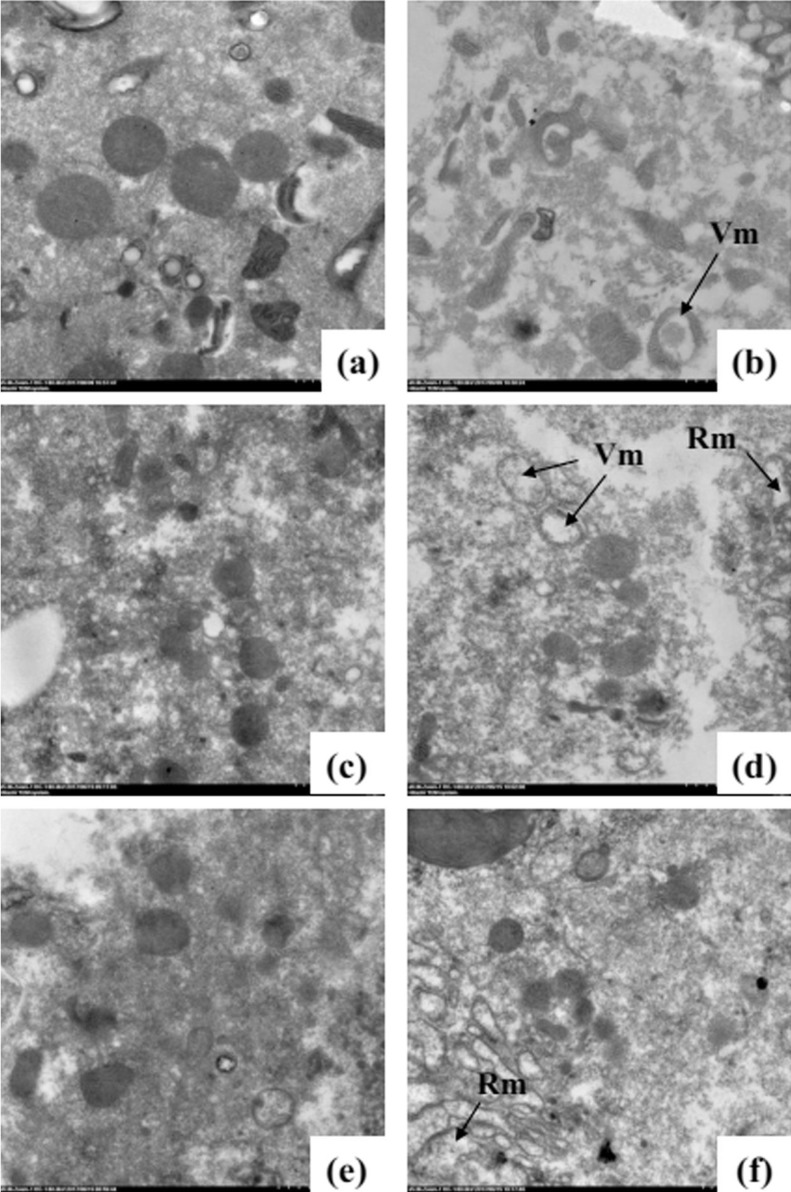
Ultra-structure of the mitochondria from the thorax of non-fumigated (A, C, and E) and fumigated (B, D, and F) T. confusum adults.(A) The normal structure of the mitochondrion with many highly electron-dense cristae. (B) A part of the thorax and ultra-structural changes in the mitochondria represented by vacuolization (Vm) and rarefaction (Rm) of the mitochondrial matrix (arrow). (C) The vacuolization aggravated 24 (B), 48 (D), and 72 h (F) after oil treatment. Scale bar = 2.0 μm.